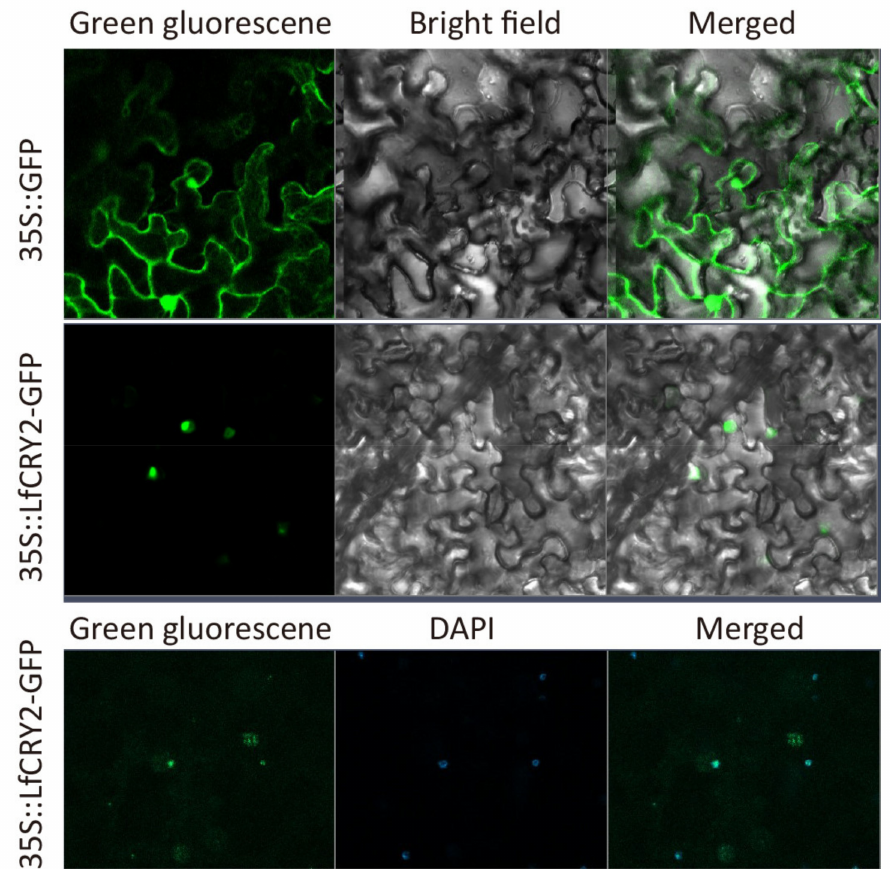
Figure 6. Subcellular localization of